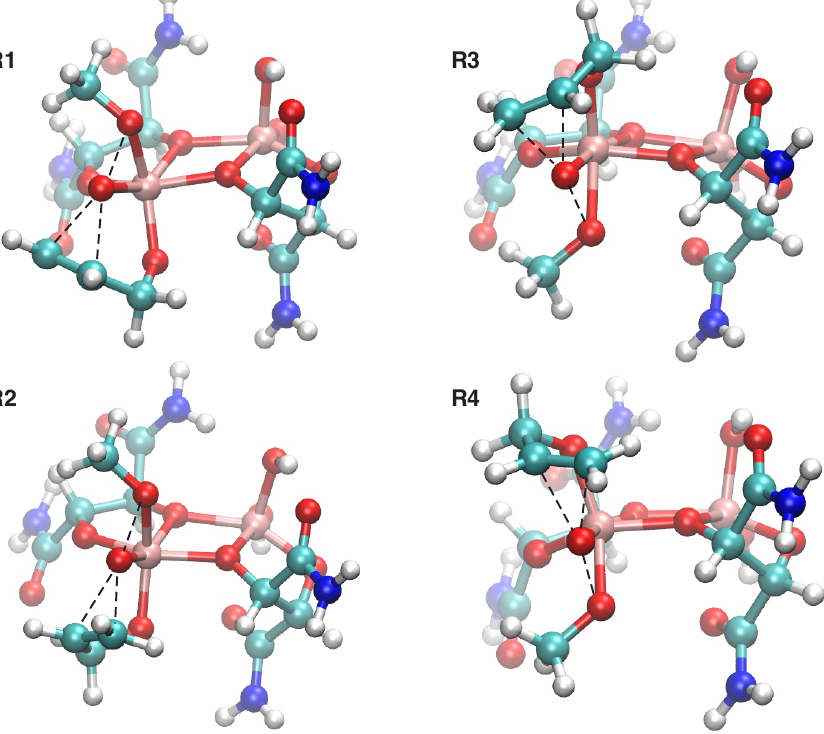
Figure 8. Transition state structures of the catalyzed epoxidation reactions between methyl– hydroperoxide and allylalcohol ( R1 – R4 ) studied in this work.